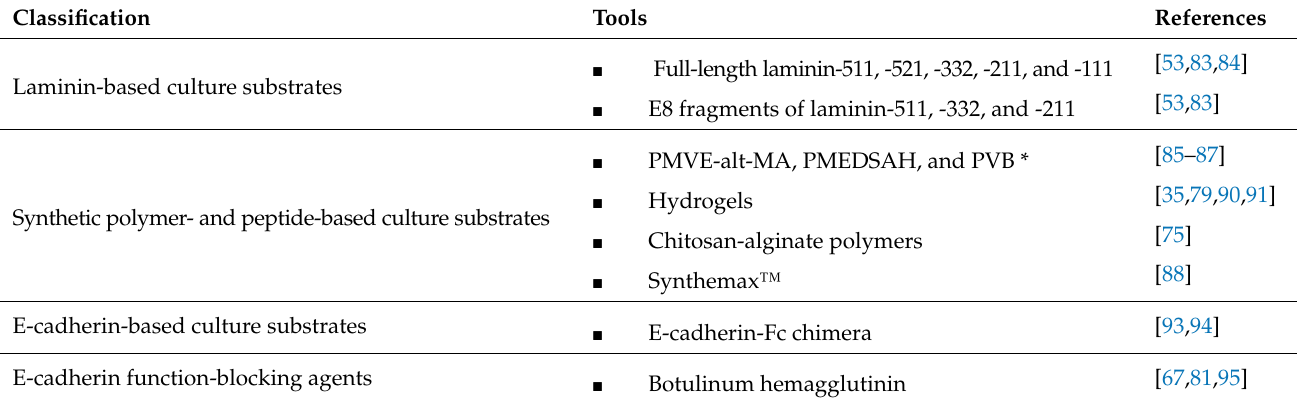
Table 1. Developed culture tools for PSC expansion and downstream